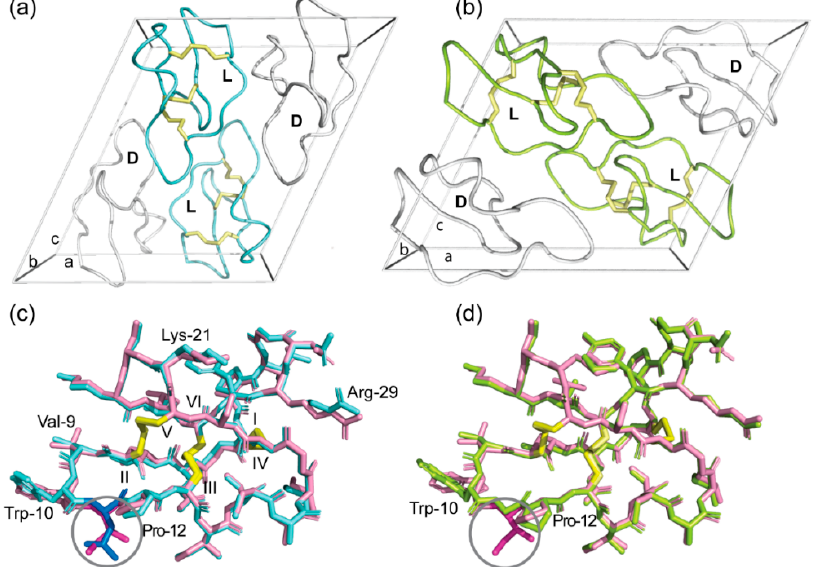
Figure 6. Racemic and quasi-racemic crystallography of [I11L]cyO2 (7RMR) and [I11G]cyO2 (7RMS). ( a ) Unit cell of the true racemate of [I11L]cyO2 in space group P1 2 1 1 with ribbon representations of the cyclic peptide molecules. The L -enantiomers are in blue and D -enantiomers in white. The disulfide bonds are shown as yellow sticks. ( b ) Unit cell of quasi-racemate of [I11G]cyO2 in space group P1 2 1 1. The [I11G]cyO2 is shown in lemon and D -[I11L]cyO2 in white. ( c ) Superimposition of cyO2 (pink) with [I11L]cyO2 (blue). The Ile and Leu residues in loop 2 are highlighted in the circle. ( d ) Superimposition of cyO2 (pink) with [I11G]cyO2 (lemon). The Ile and Gly residues in loop 2 are highlighted in the circle.